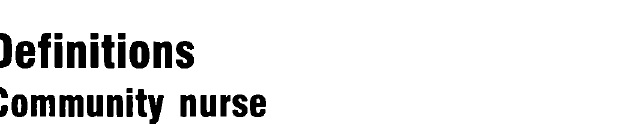
Table 1 : Number of meetings attended by Community nurse respondents NUMBER OF